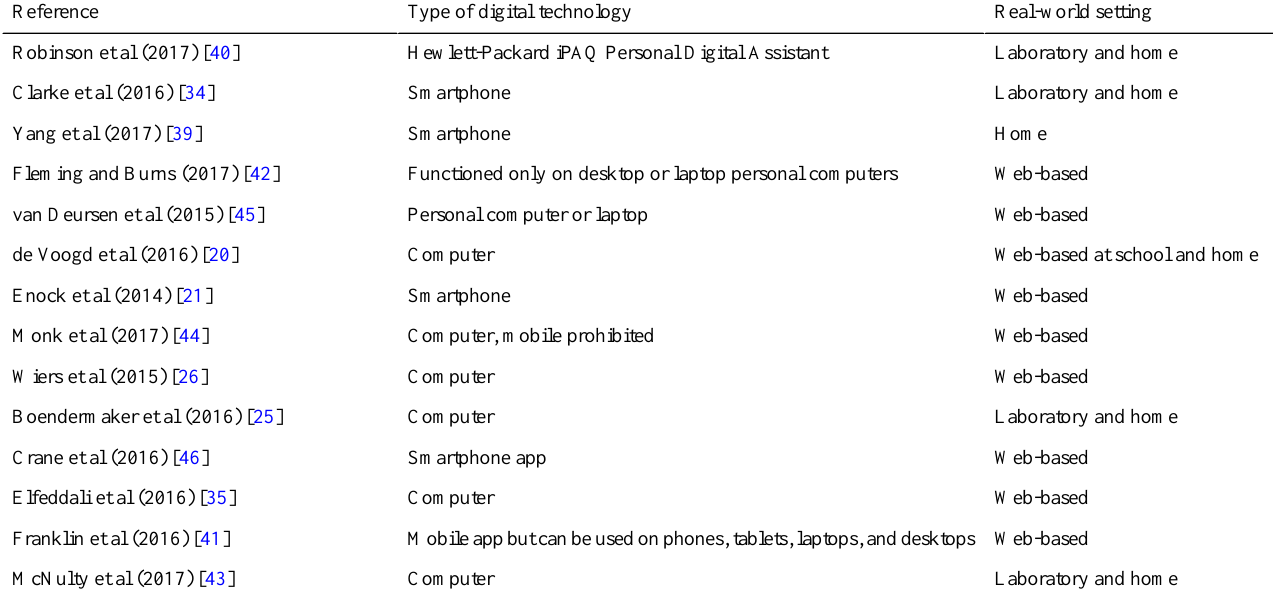
Table 2. Intervention characteristics of included studies (n=14).